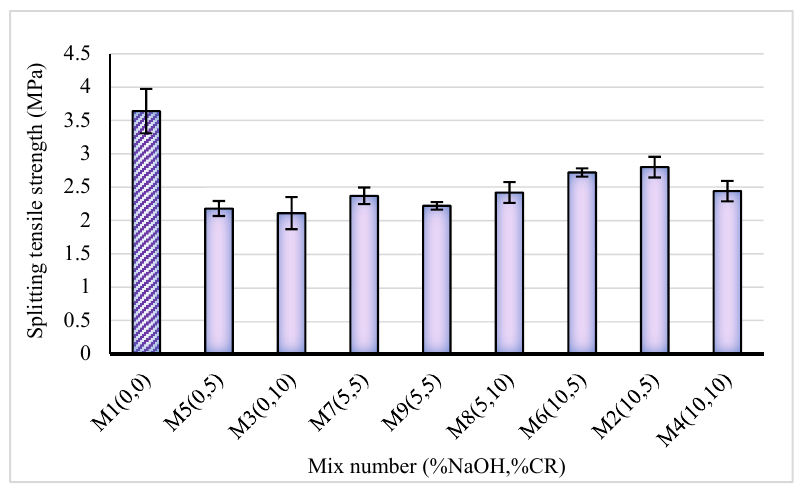
Figure 8. Splitting tensile strength of NaOH-CRC at 28 days.